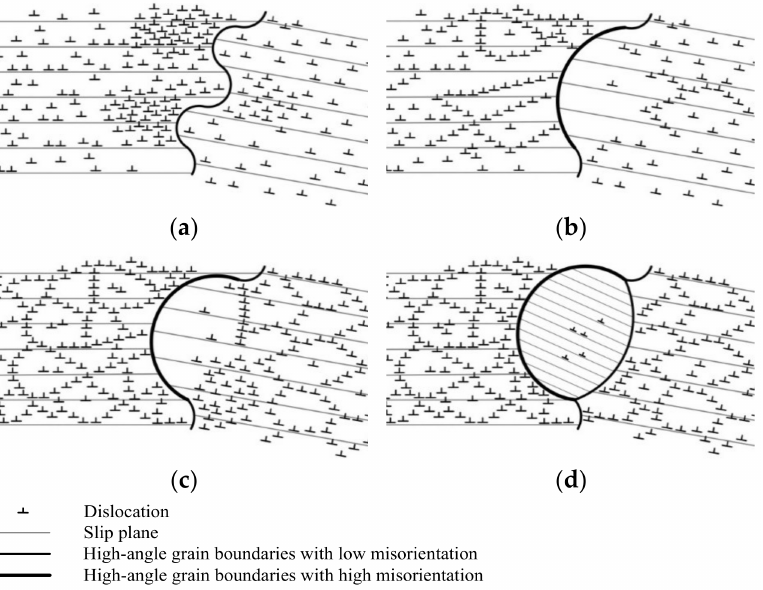
Figure 9. Schematic diagram showing the nucleation model of DRX randomly occurred along the original high-angle grain boundaries by grain boundary bulging. (Note that only dislocations of one sign are shown in the schematic diagram for simplifying model.) ( a ) The formation of serrated grain boundary. ( b ) Grain boundary bulging. ( c ) The formation of subgrain boundary behind the bulged regions. ( d ) DRX grain